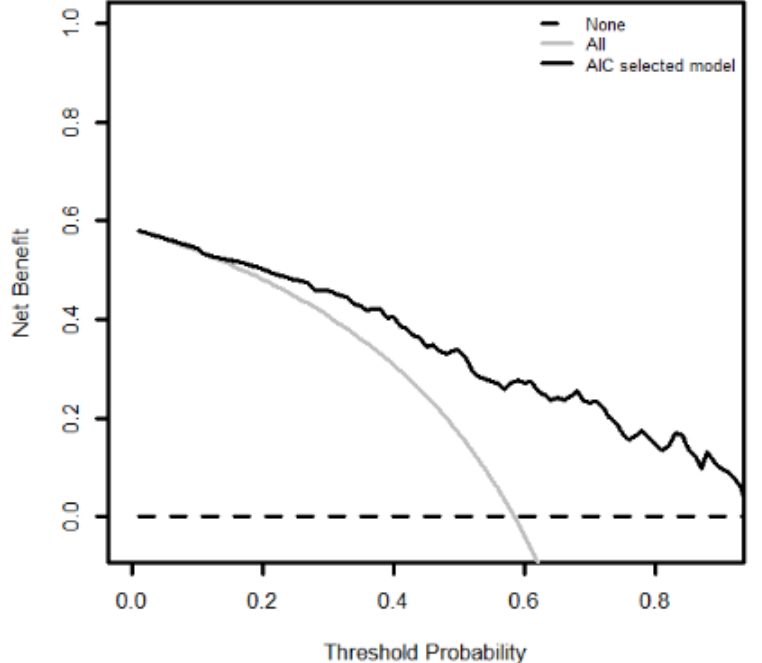
Figure 4. The decision curve plotting of net benefit against threshold probability for nomogram predicting severe periodontitis according to WWC classification. (WWC: World Workshop on the Classification of Periodontal and Peri-Implant Diseases and Conditions ).